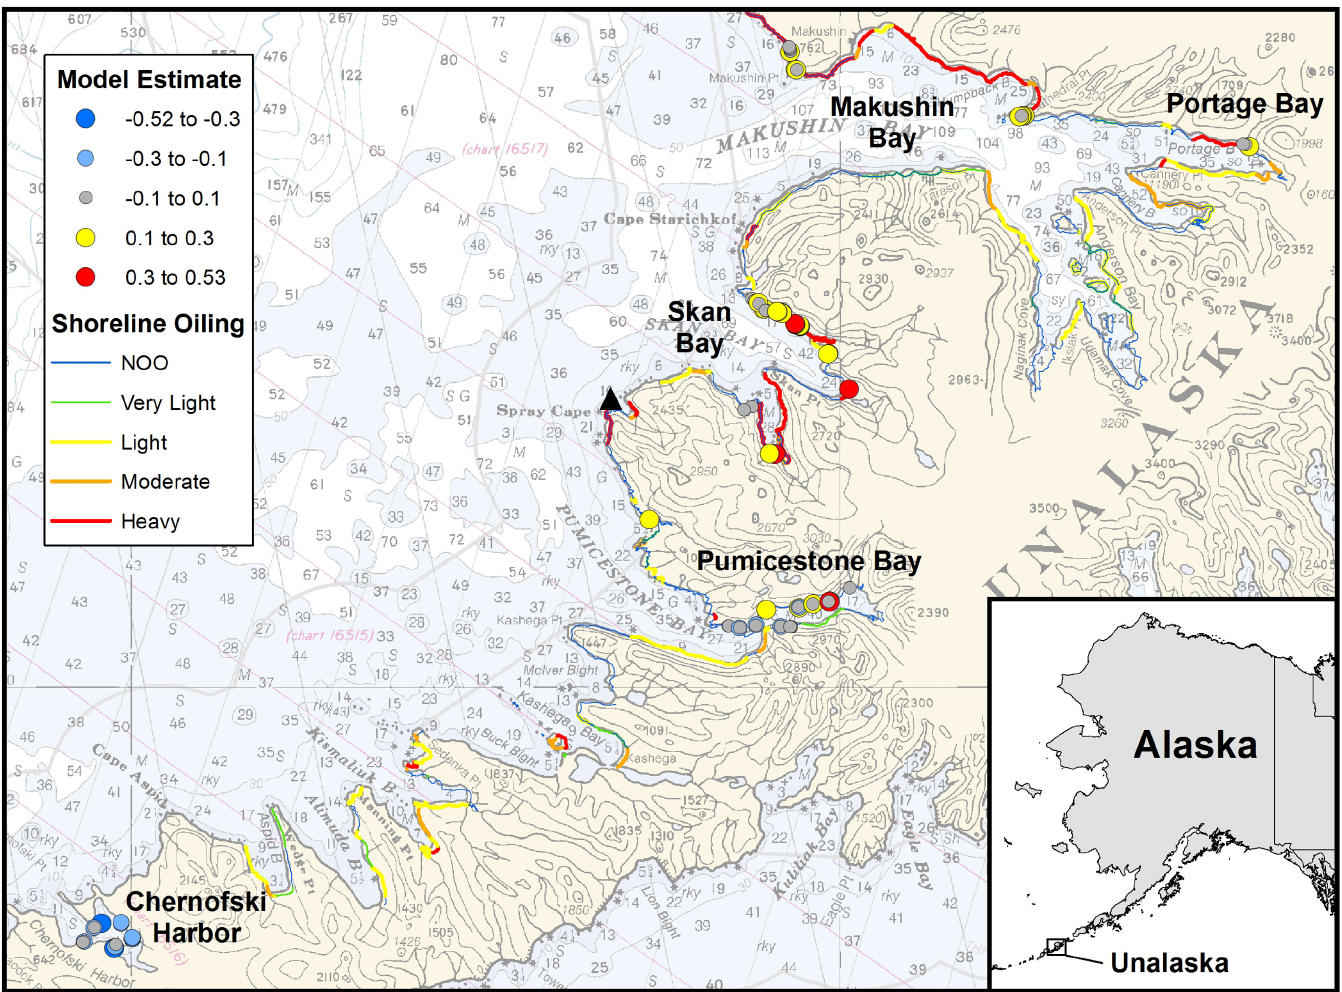
Fig 1. PAH model results for mussel tissue (2008) within the previous S . Ayu spill area, historically contaminated (Chernofski Harbor), and reference areas (Pumicestone Bay). Shoreline oiling was assessed in 2005. The black triangle marks the location of the wreck. The basemap is NOAA chart 16500 (http://www.charts.noaa.gov/OnLineViewer/16500.shtml).